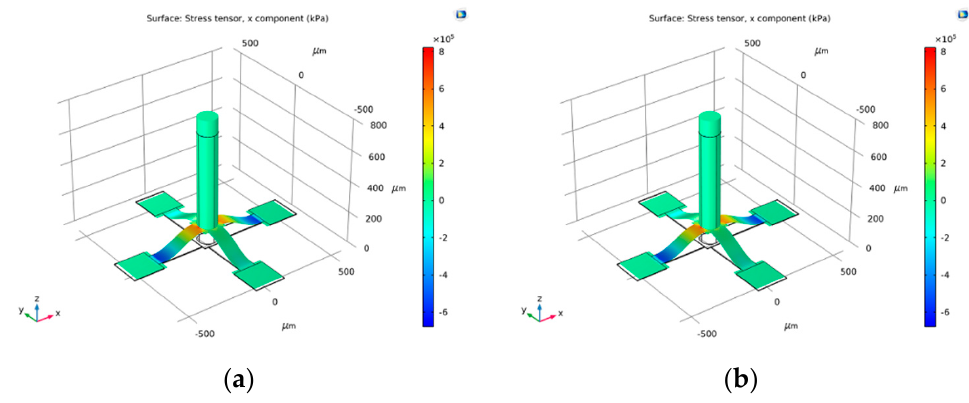
Figure 12. Stress tensor contours: ( a ) buckling stress contours; ( b ) post-buckling stress contours.